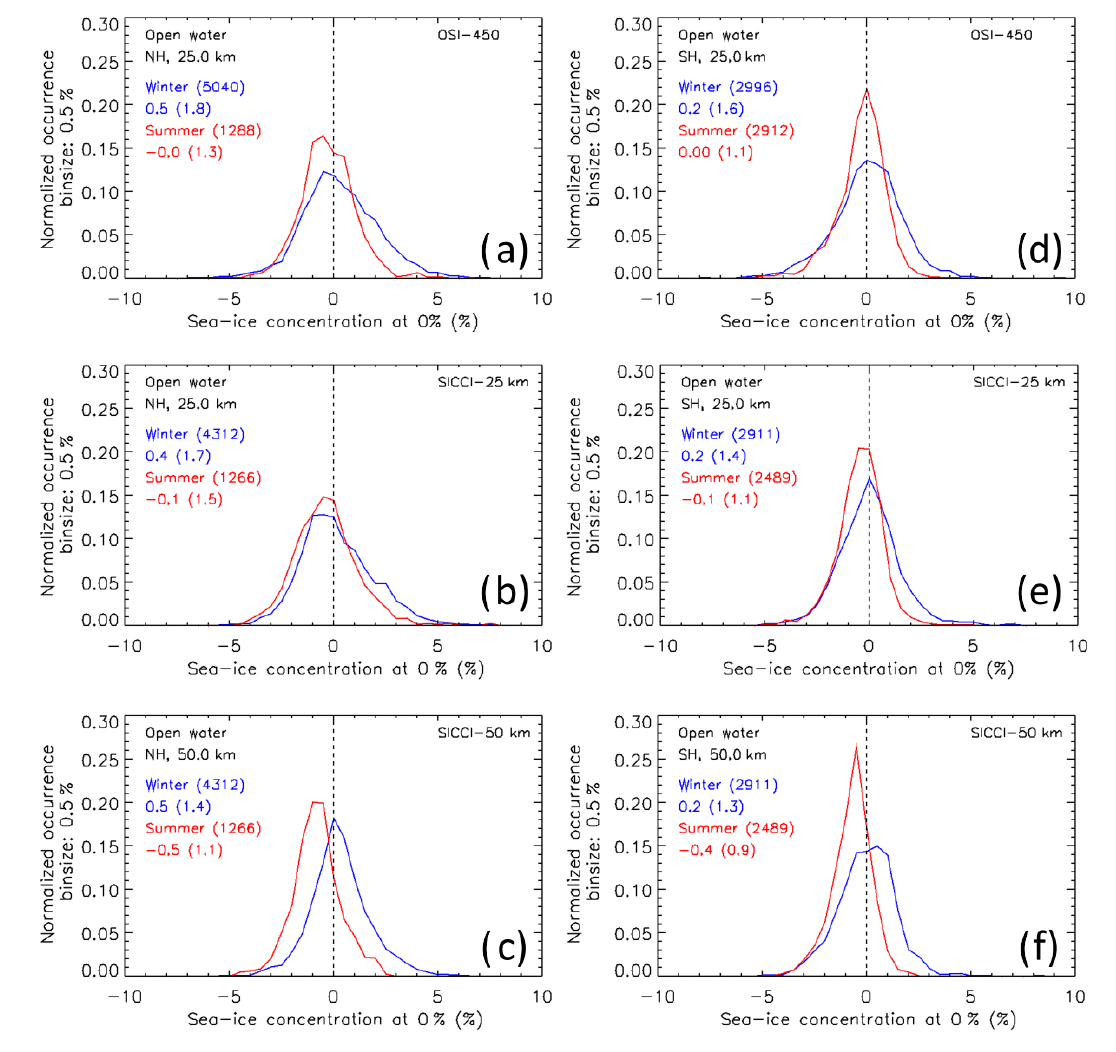
Figure 10. SIC distribution around SIC = 0% at the selected open-ocean locations for, from top to bottom, OSI-450, SICCI-25km, and SICCI-50km in the Arctic (a–c) and the Antarctic (d–f) . The unfiltered distribution is shown (no OWF) by combining ice_conc and raw_ice_conc_values variables. Blue (red) curves and numbers refer to results from winter (summer); the numbers in parenthesis behind the season denote the count of cases used. Numbers below the season denote the mean SIC and 1 standard deviation (in parenthesis) in percent SIC. Bin size is 0.5%. Distributions are normalized to give a total of